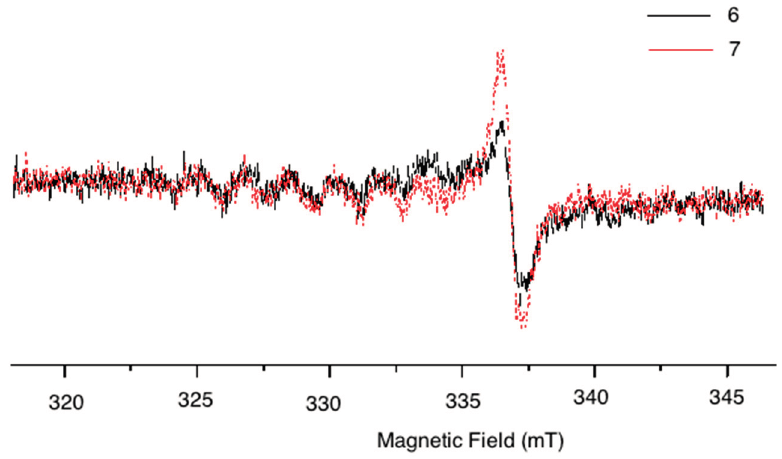
Figure 3. EPR spectra of compounds 6 and 7